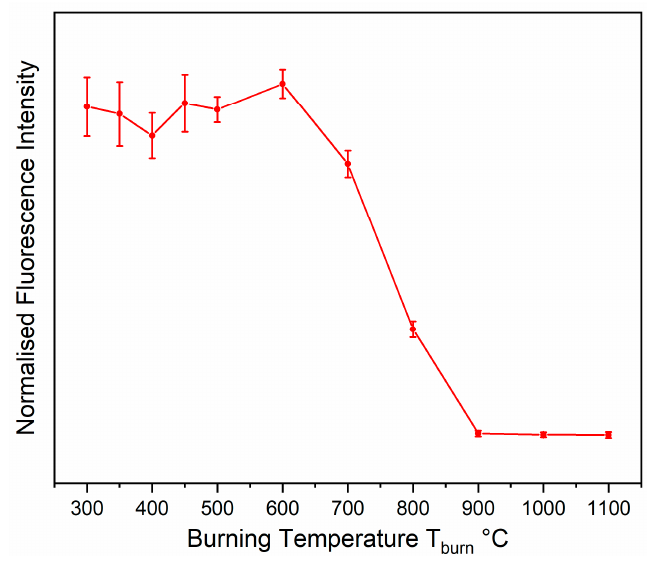
Figure A4. Normalised fluorescence intensity of anhydrite II as a function of its burning temperature calculated as the ratio of measured autofluorescence and Raman intensities.